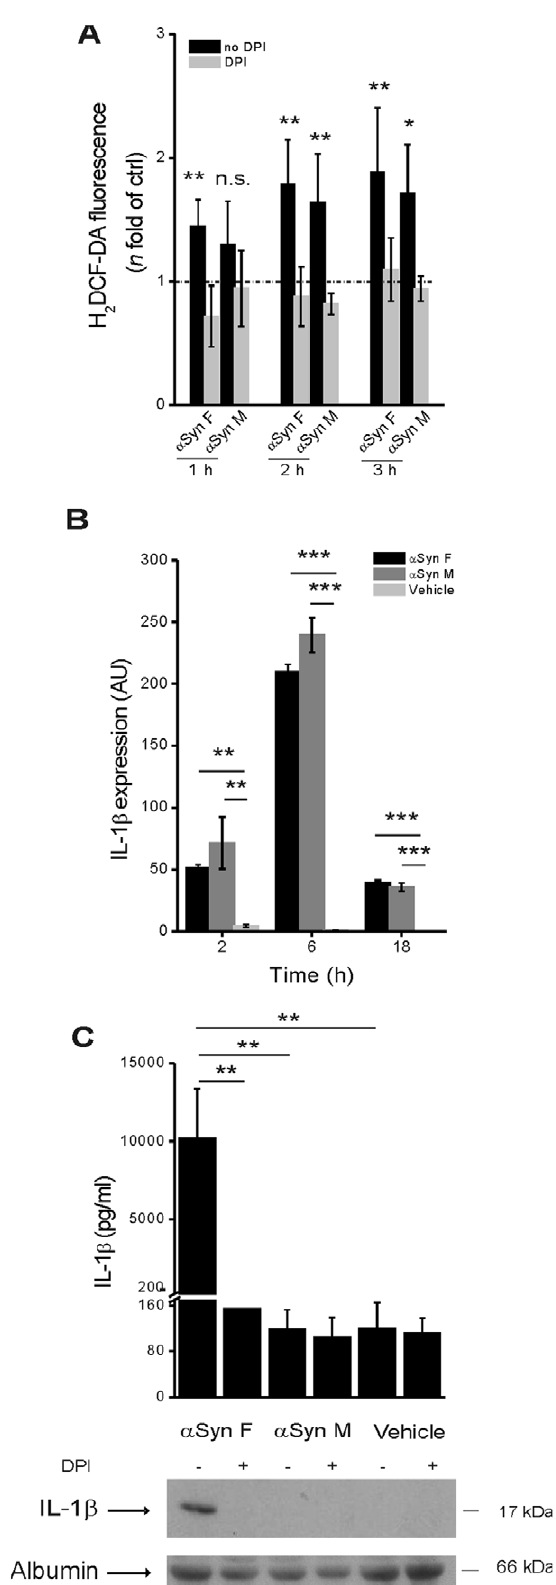
Figure 5. Only a Syn F is capable of activating the inflamma- some. (A) Monocytes were cultured for 1, 2 or 3 h in the presence of 40 nM a Syn F or 1 m M a Syn M and intracellular ROS levels